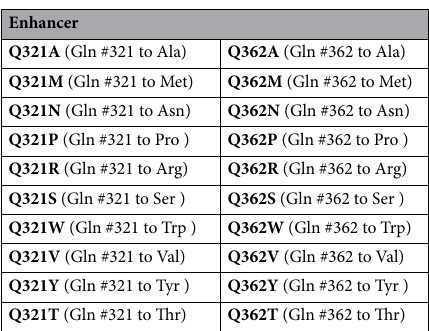
Table 6. Glutamine (Gln/Q) amino acid mutants.